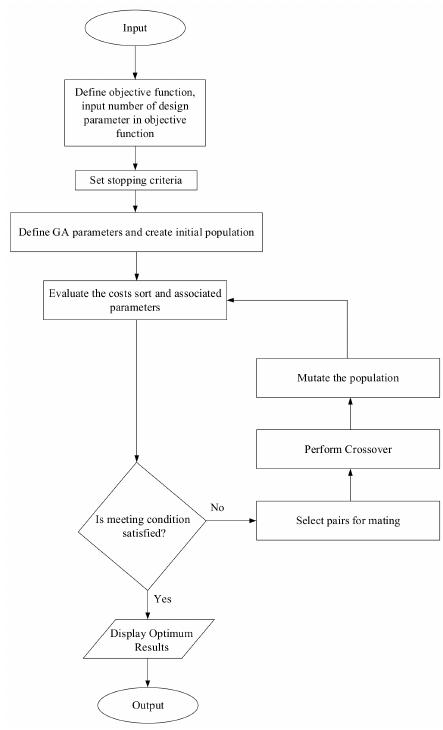
Figure 1. Flow chart of